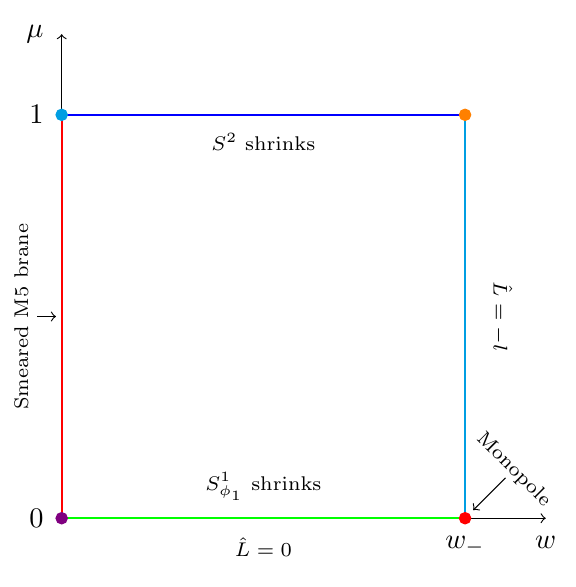
Figure 1. A schematic plot of the rectangle over which the S 2 × S 1 interior of the rectangle all the fibers remain of finite size, whilst along the boundary various cycles shrink. The red dot on the bottom right hand corner is the location of a monopole of charge l